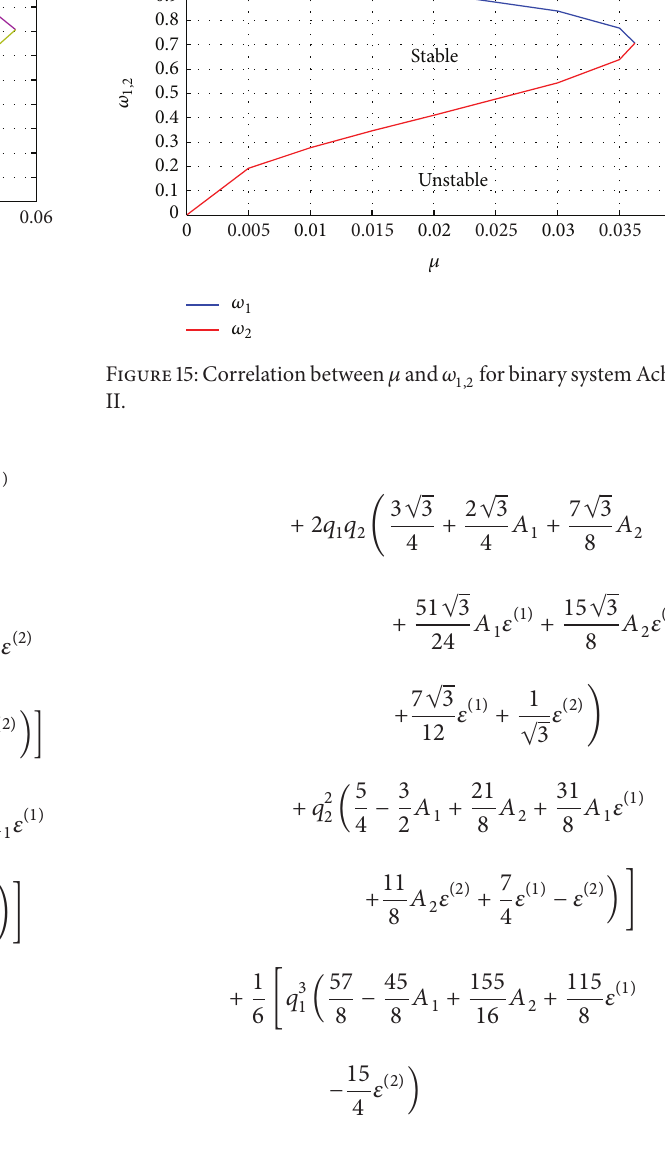
Figure 13: Combined graph for Figures 5, 6, and 7.